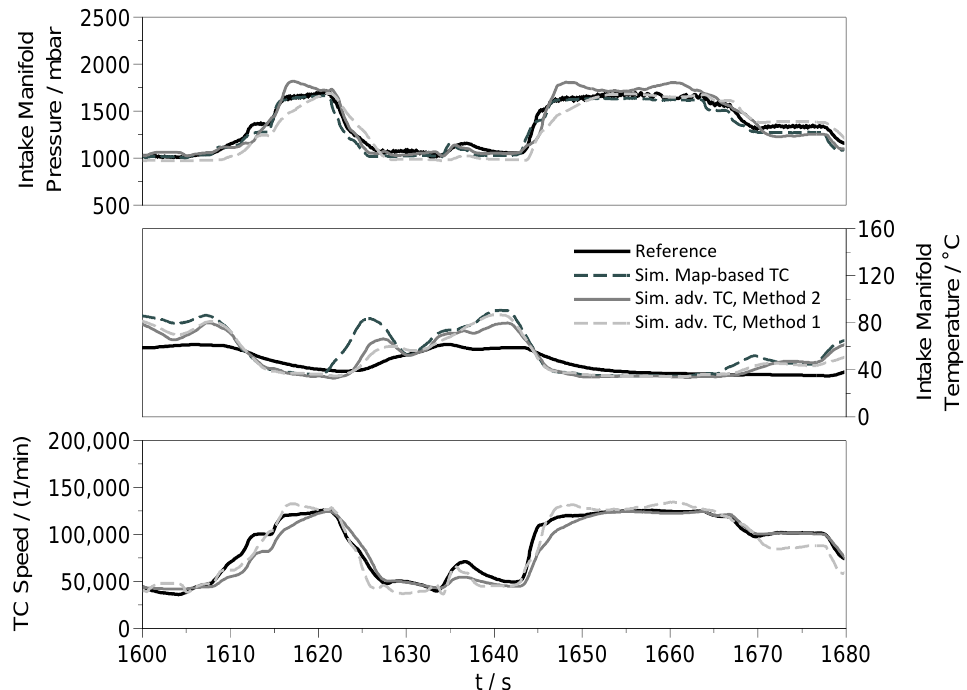
Figure 6. Verification of the engine model compared to chassis dynamometer measurements with different TC modeling approaches.